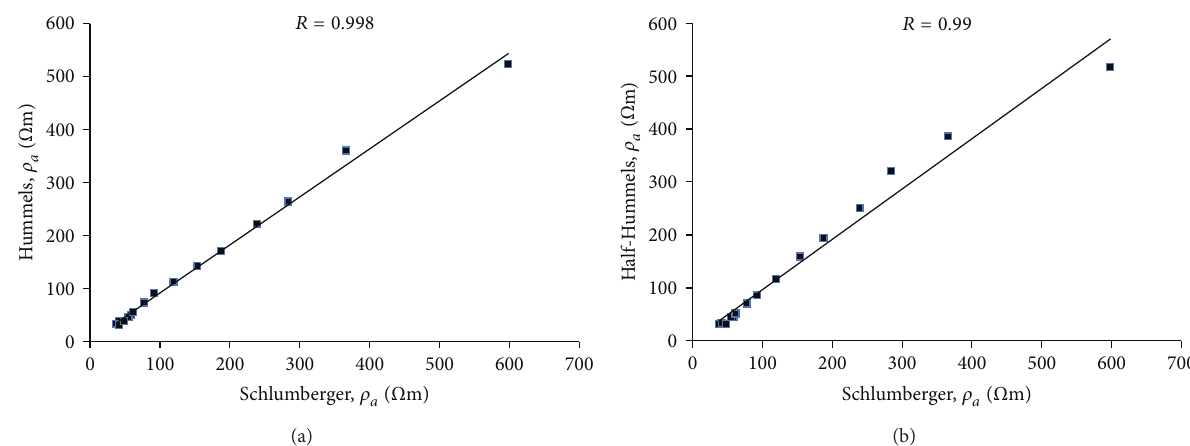
Figure 16: Statistical plot of apparent resistivity data for location 4 (banded gneiss) (a) Hummel against conventional Schlumberger (VES) and (b) “Half-Hummel” against conventional Schlumberger (VES).